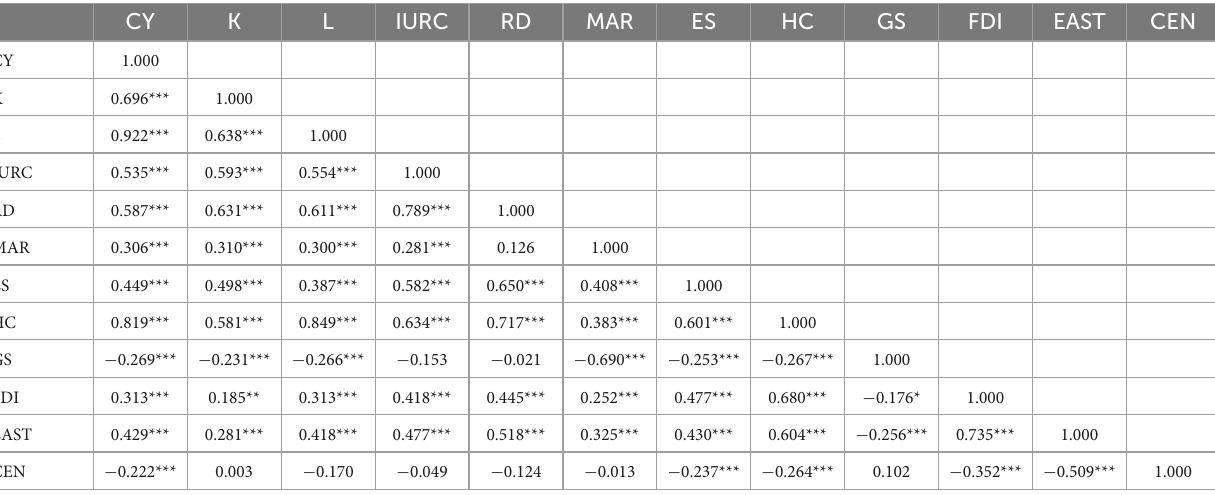
TABLE 3 Correlation matrix of variables.